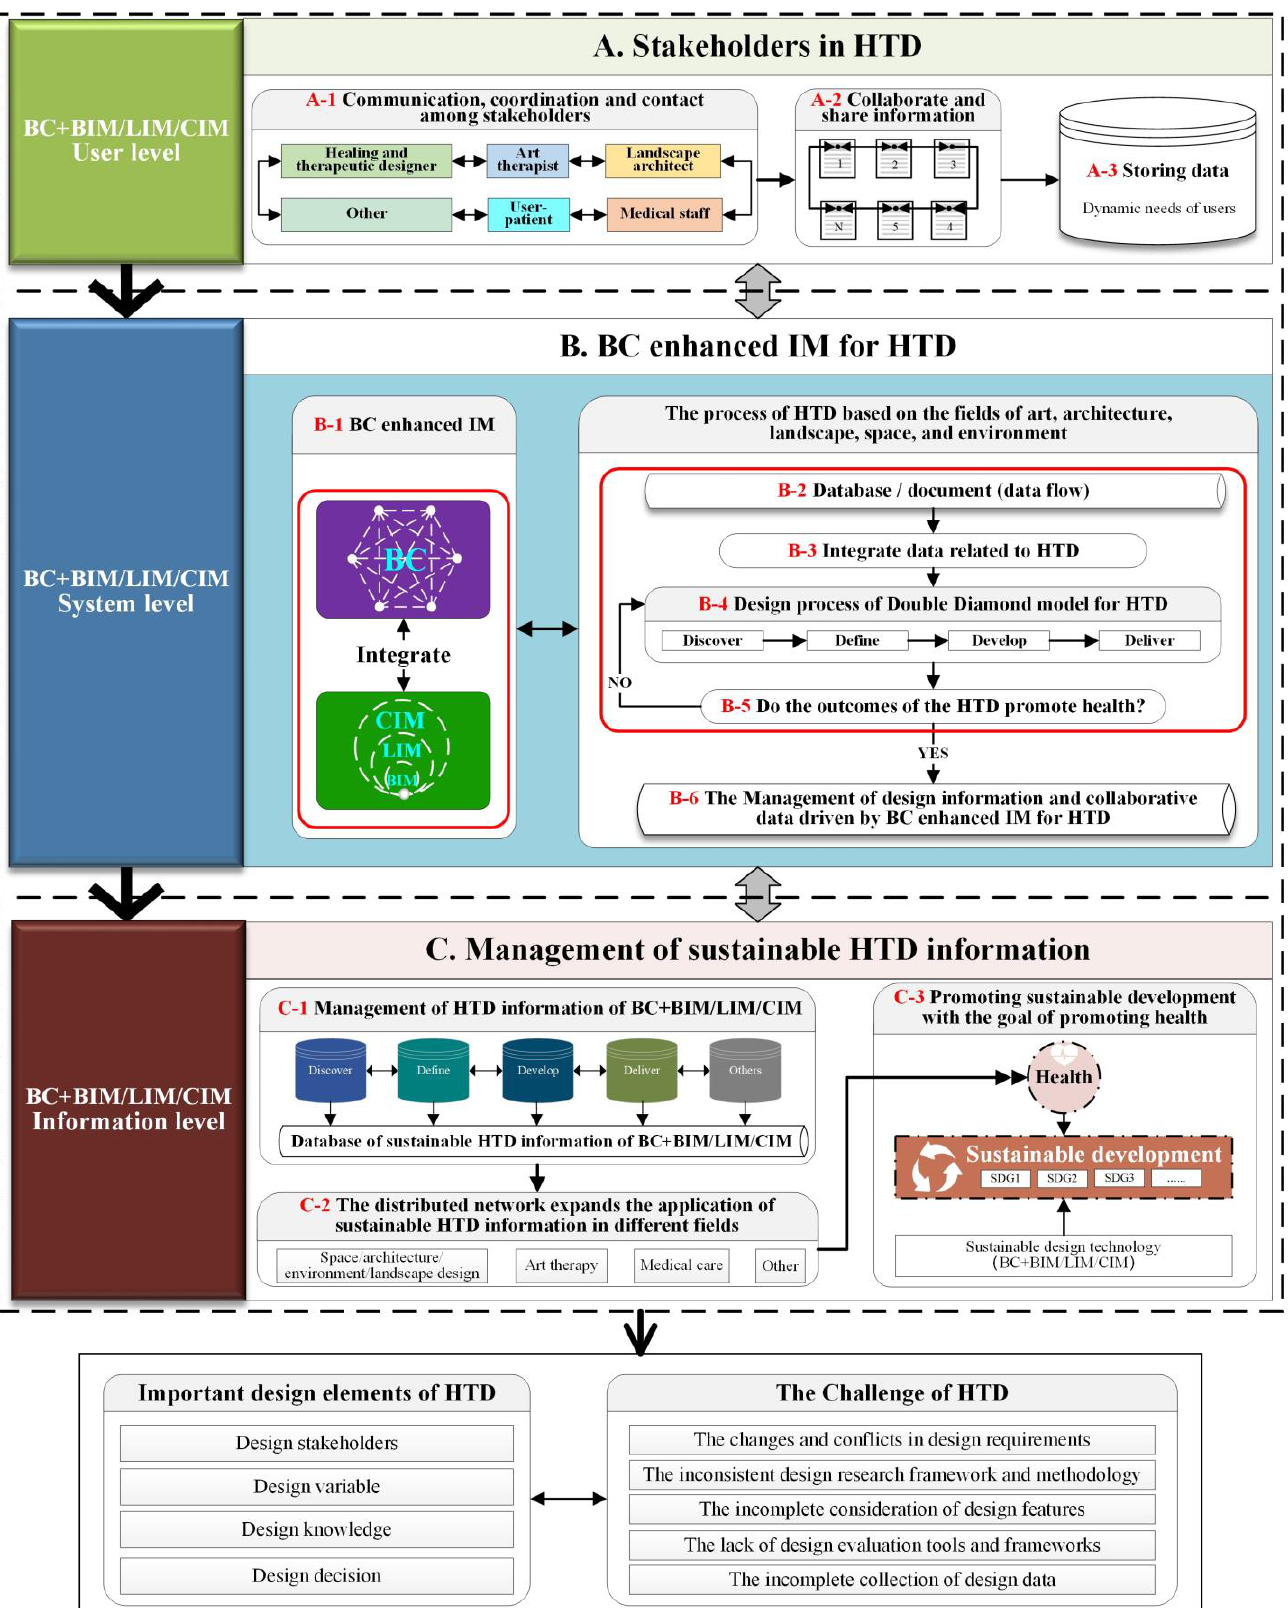
Figure 9. High-level BC-HTD framework (generated by authors).